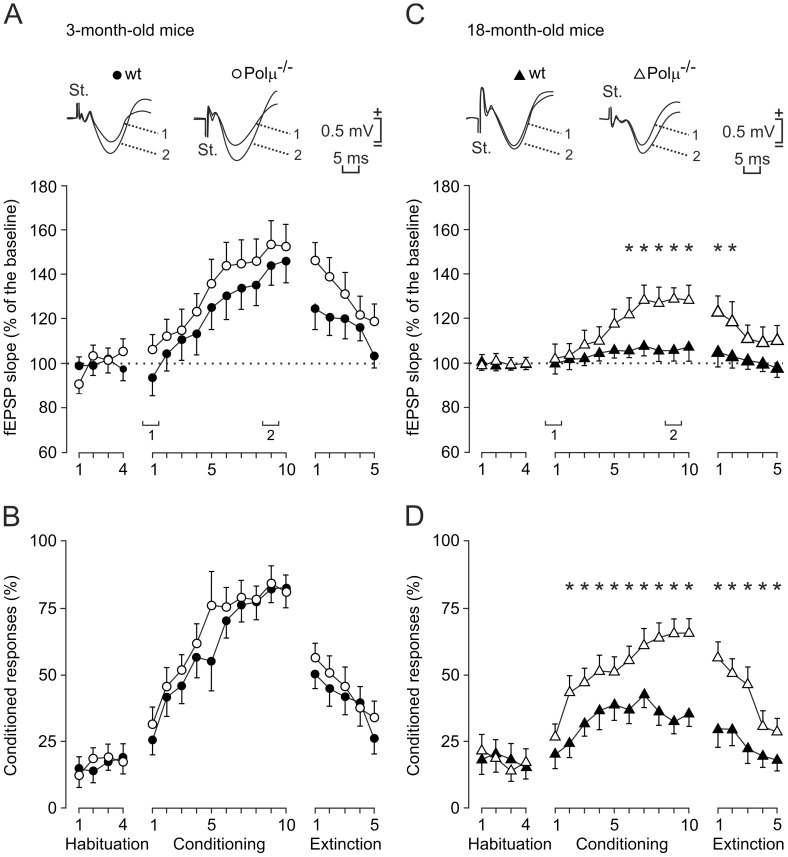
Learning curves and evolution of the evoked field potential (fEPSP) at the CA3-CA1 synapse for young and aged Polµ−/− and wild-type mice, across training.(A, B) Evolution of the fEPSP slope (A) and of the percentage (%) of conditioned responses (CRs, B) for 3-month-old wild-type (black circles) and Polµ−/− (white circles) mice, during habituation, conditioning, and extinction sessions. At the top are illustrated averaged (n = 5) fEPSPs collected from the 1st and 9th conditioning sessions. (C, D) A similar set of data collected from 18-month-old wild-type (black triangles) and Polµ−/− (white triangles) animals. Mean % values are followed by ± SEM. Differences in the percentage of CRs between 18-month-old wild-type and Polµ−/− animals were statistically significant as indicated (*P<0.001, two-way ANOVA). Differences in fEPSP slopes are also indicated, expressed as the % change with respect to mean values collected during the last two-habituation sessions (*P<0.001, two-way ANOVA).